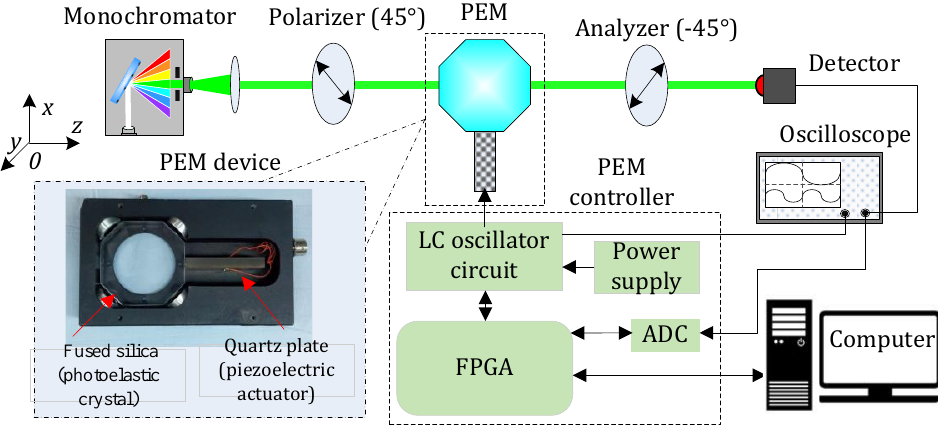
Figure 2. Schematic diagram of the experimental system. The inset shows a PEM device. A xenon lamp monochromator (Omni- λ 200, Zolix Instruments Co., Ltd., Beijing, China), in the